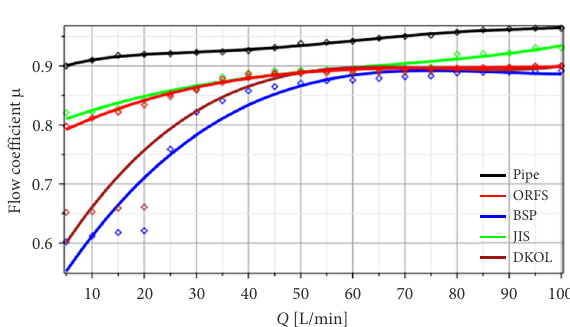
Figure 12. A chart of the flow coefficient at a different flow rate of fitting